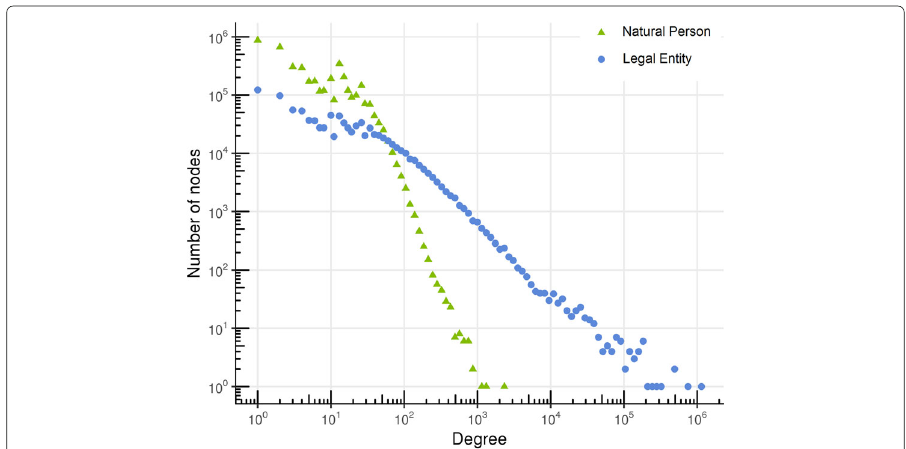
Fig. 6 Degree distribution by customer type: natural person (green) or legal entities (blue) in the 2017 wire transfer